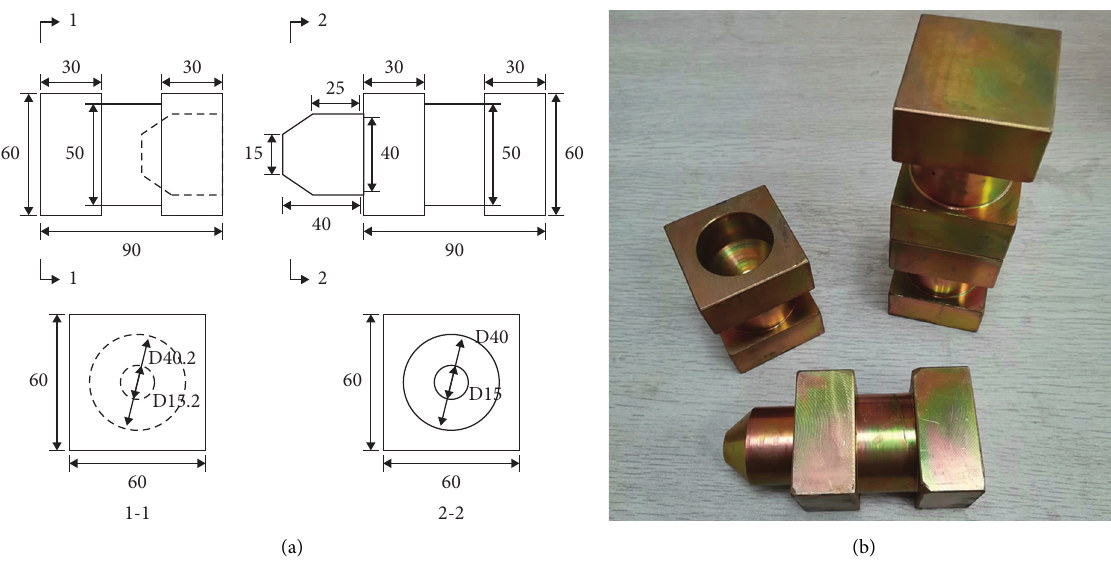
Figure 2: Design and model of the steel shear key. (a) Size and (b) model (unit: mm).